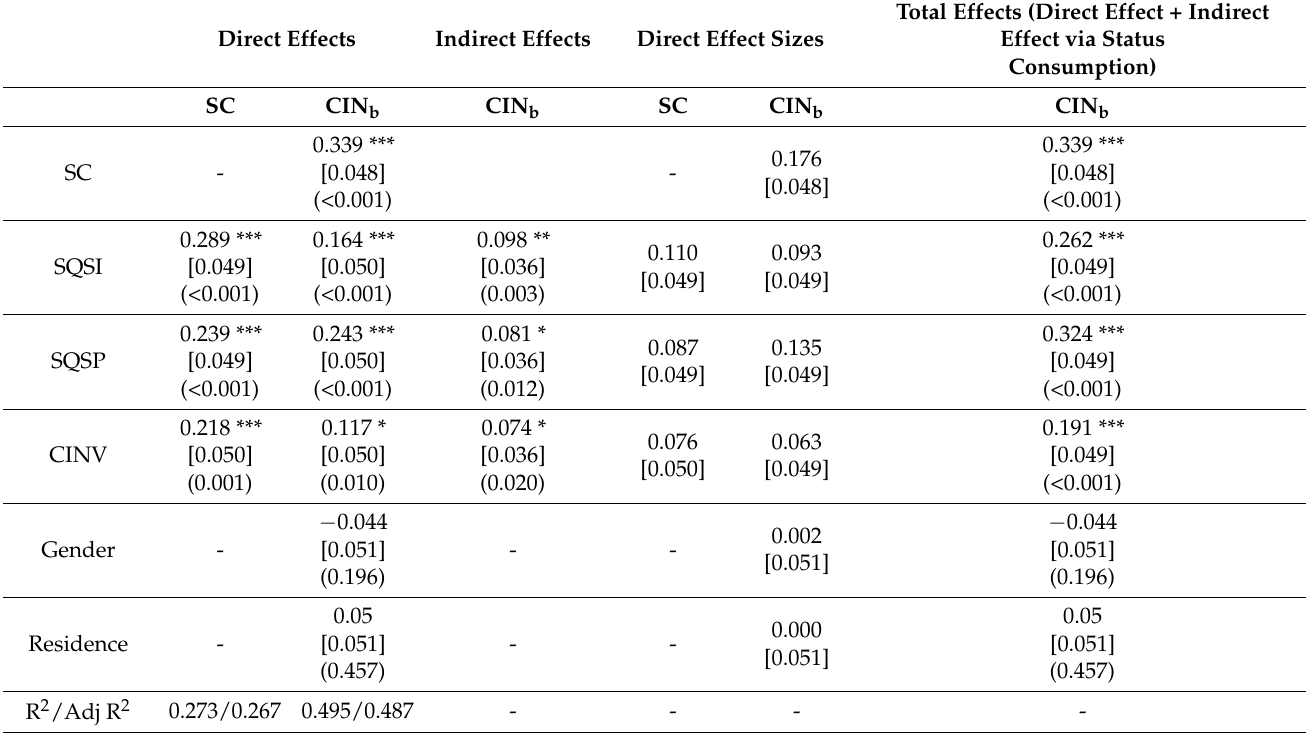
Table 11. The third structural equation